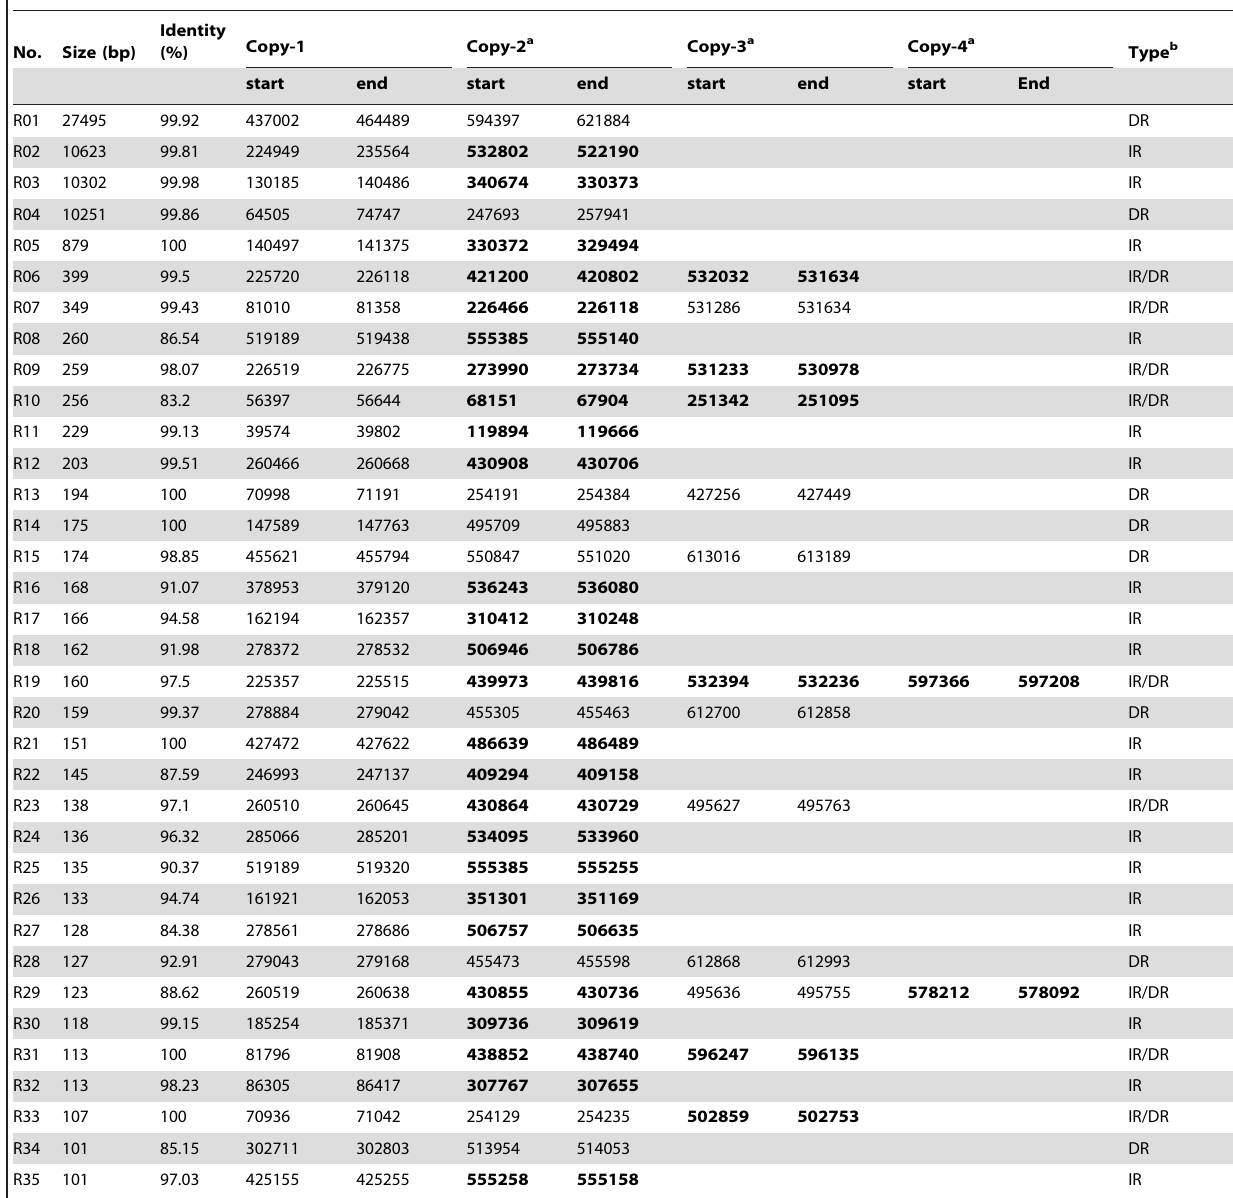
Table 2. Repeats ( . 100 bp) in Gossypium hirsutum mt genome.